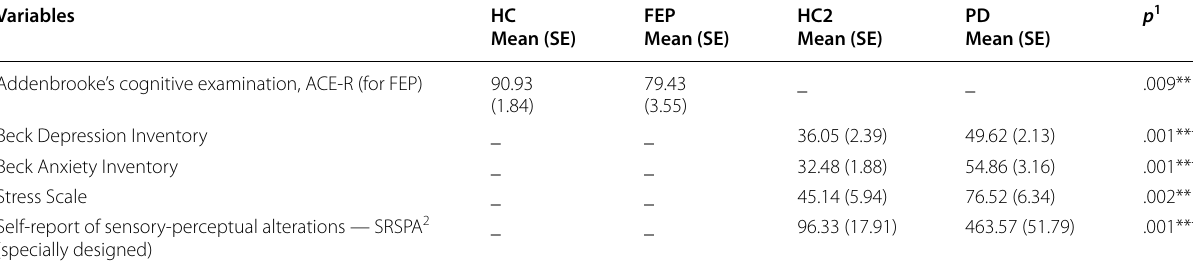
Table 2 Group characteristics on assessment: mean scores, respective standard errors (SE), and probabilities for FEP vs HC and PD vs